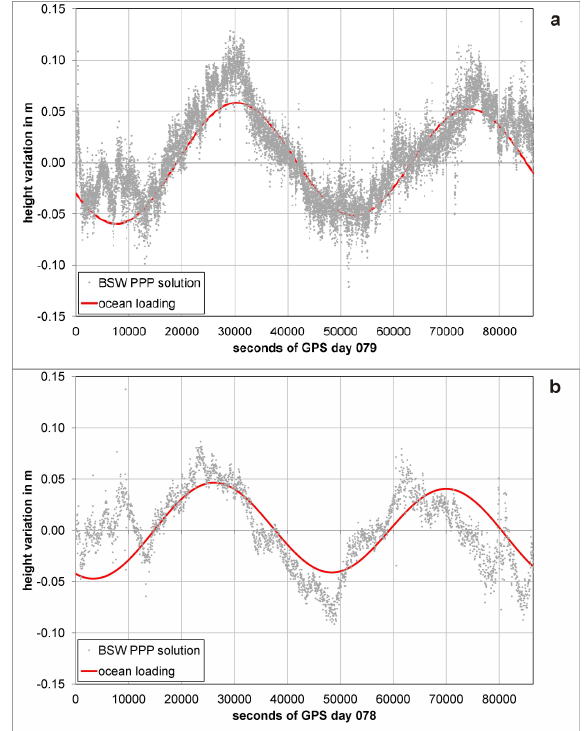
Figure 11. Height variation of kinematic PPP solutions and vertical displacement from ocean tide loading for reference sta- tions in Funchal (a) and Sta. Cruz de Tenerife